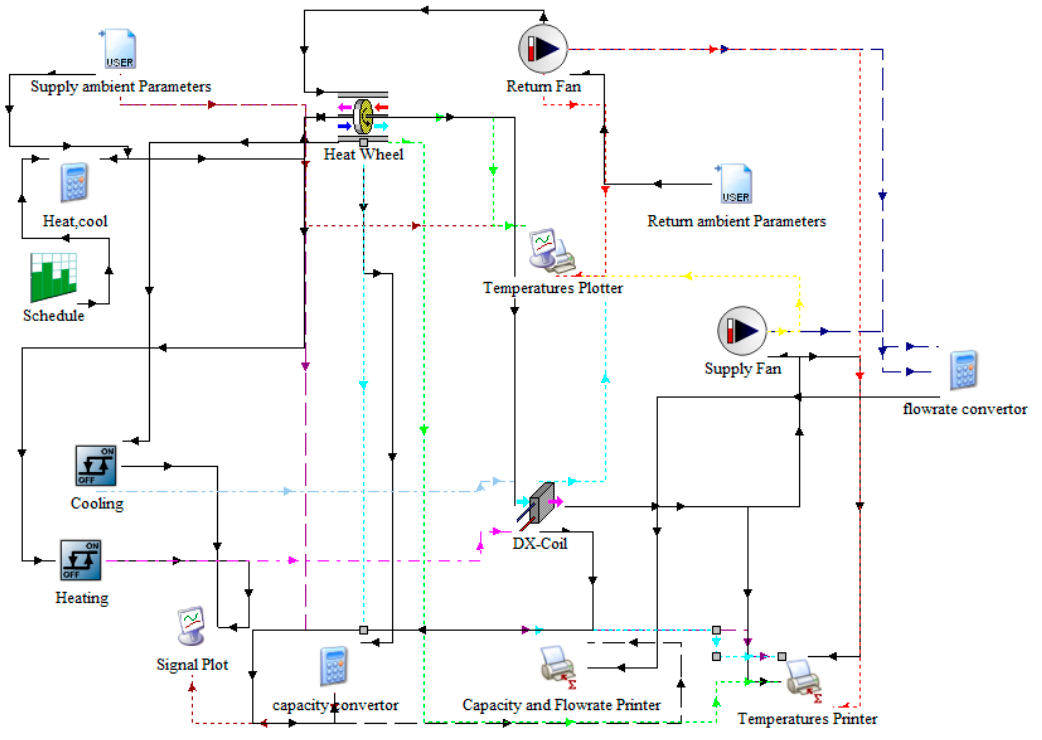
Figure 4. TRNSYS simulation model.